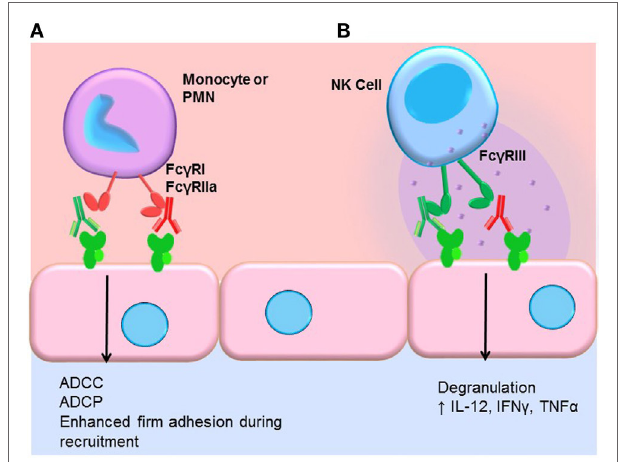
FiGURe 3 | Fc γ R-mediated effector functions . (A) Monocytes and neutrophils express Fc γ Rs, which bind preferentially to different IgG subclasses. Fc γ R cross-linking by myeloid cells induces activation and mediates antibody-dependent cell-mediated cytotoxicity (ADCC), phagocytosis (ADCP), and augments recruitment of leukocytes from the blood. In general, IgG1 and IgG3 efficiently bind to most Fc γ R isoforms expressed by monocytes and neutrophils. IgG4 can bind quite well to Fc γ RI (CD64), and IgG2 is bound by an allelic variant of Fc γ RIIa (CD32a, H131). (B) NK cells express Fc γ RIII (CD16). Engagement of Fc γ RIII by antibody- coated target cells induces ADCC via degranulation and release of perforin/ granzyme. Cross-linking of Fc γ RIII on NK cells also upregulates the inflammatory cytokines IL-12, IFN γ , and TNF α